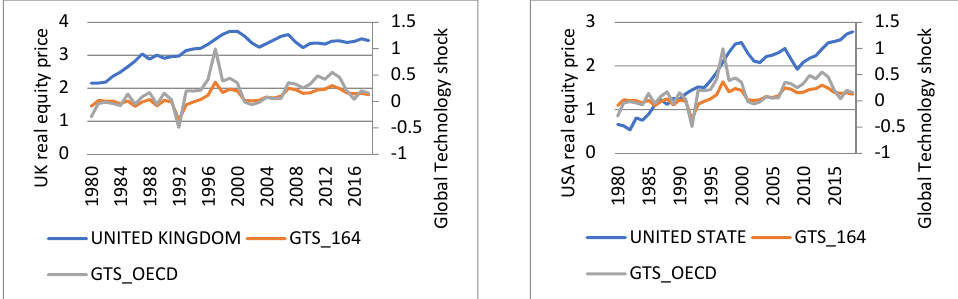
Figure A1. Country − level co-movement of real equity prices and technology shock.